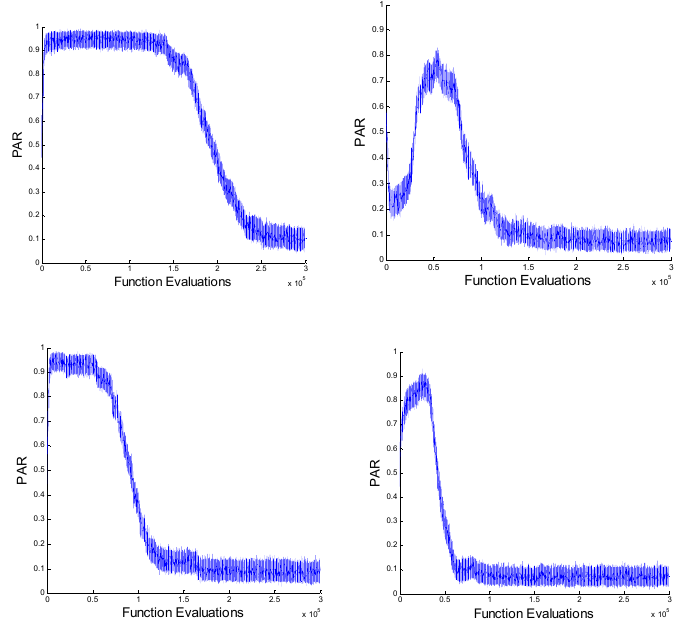
Figure 3. How pitch adjusting rate (PAR) changes f1, f10, f21, f28.